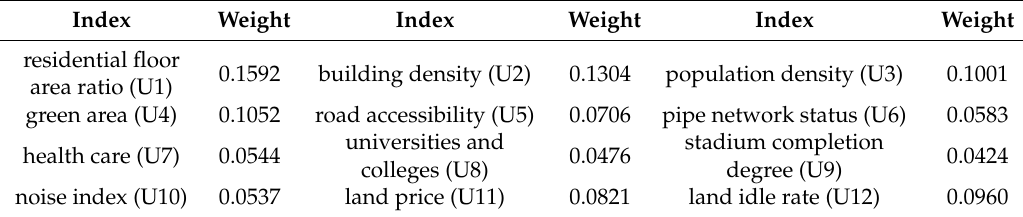
Table 1. Evaluation index weighting coefficient